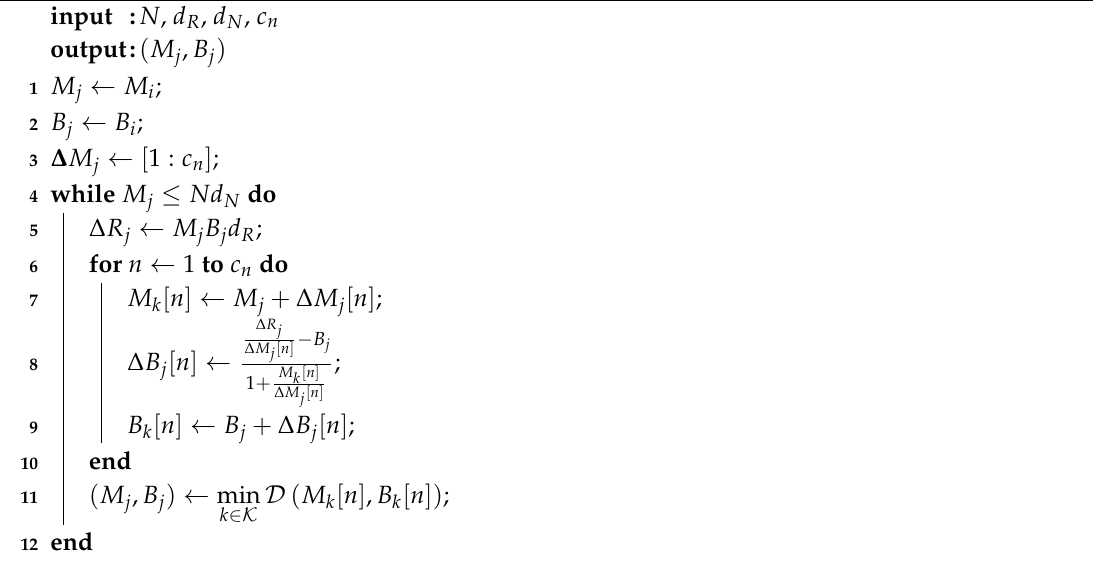
Algorithm 1: Construction of the successive approximation